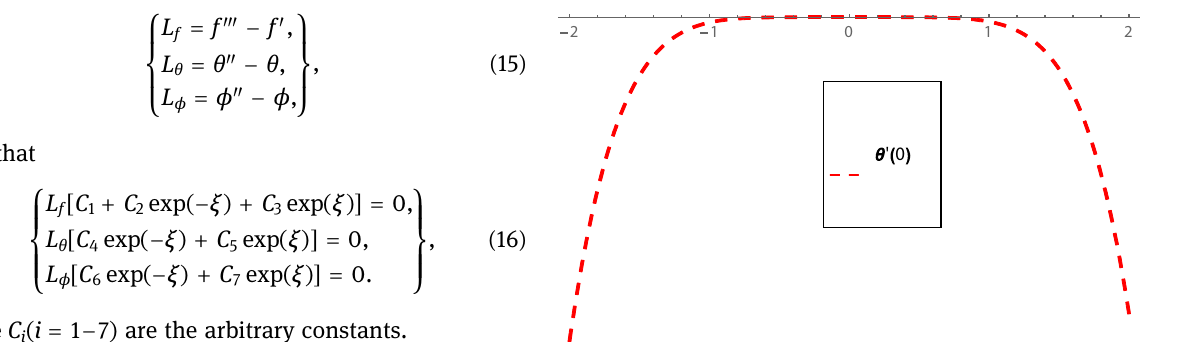
Figure 3: h Curve - for θ ′ 0 (